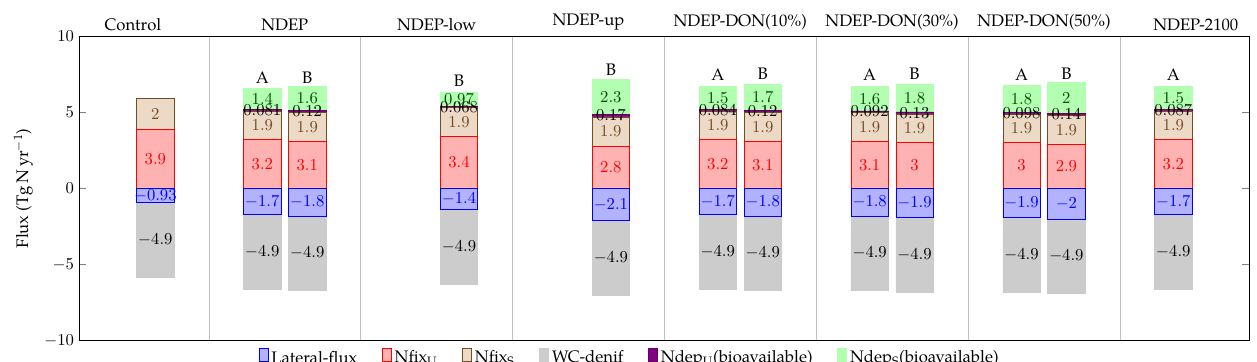
Figure 5. Sensitivity of nitrogen fluxes to atmospheric inorganic and organic nitrogen deposition and associated uncertainties. Lateral- flux is the nitrogen efflux or influx through the southern boundary; Nfix U and Nfix S represent the bioavailable nitrogen fixation rate by NF in the U and S boxes, respectively; WC-denif is water-column denitrification; Ndep U and Ndep S are the nitrogen input into surface ocean (U and S boxes) via nitrogen deposition. Bar labels: A, nitrogen deposition data from Lamarque et al. (2011); B, nitrogen deposition data from Dentener et al. (2006). In NDEP-low and NDEP-up, the lower and upper limit of nitrogen deposition fluxes are included; in NDEP-DON(10%), NDEP-DON(30%) and NDEP-DON(50%), the bioavailability of deposited DON is assumed to be 10, 30 and 50%, respectively; in NDEP-2100, nitrogen deposition is estimated according to the RCP8.5 scenario projections for 2100 (Lamarque et al., 2011).